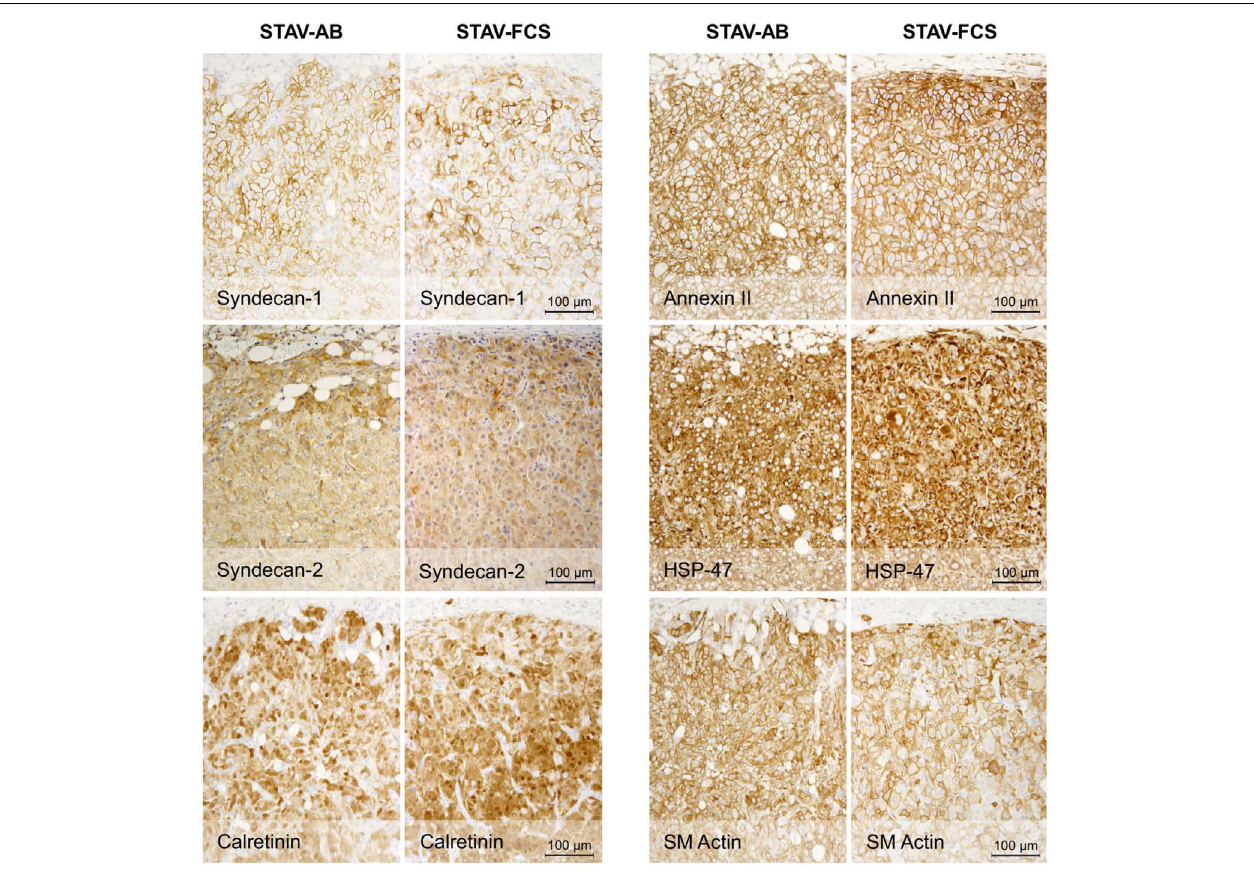
FIGURE 4 | Immunohistochemical staining of xenografts for mesothelial and mesenchymal differentiation markers . Xenografts from both cell sub-lines stained uniformly and similarly positive for Syndecan-1, Syndecan-2, Calretinin, Annexin-II, HSP47, and SM actin.